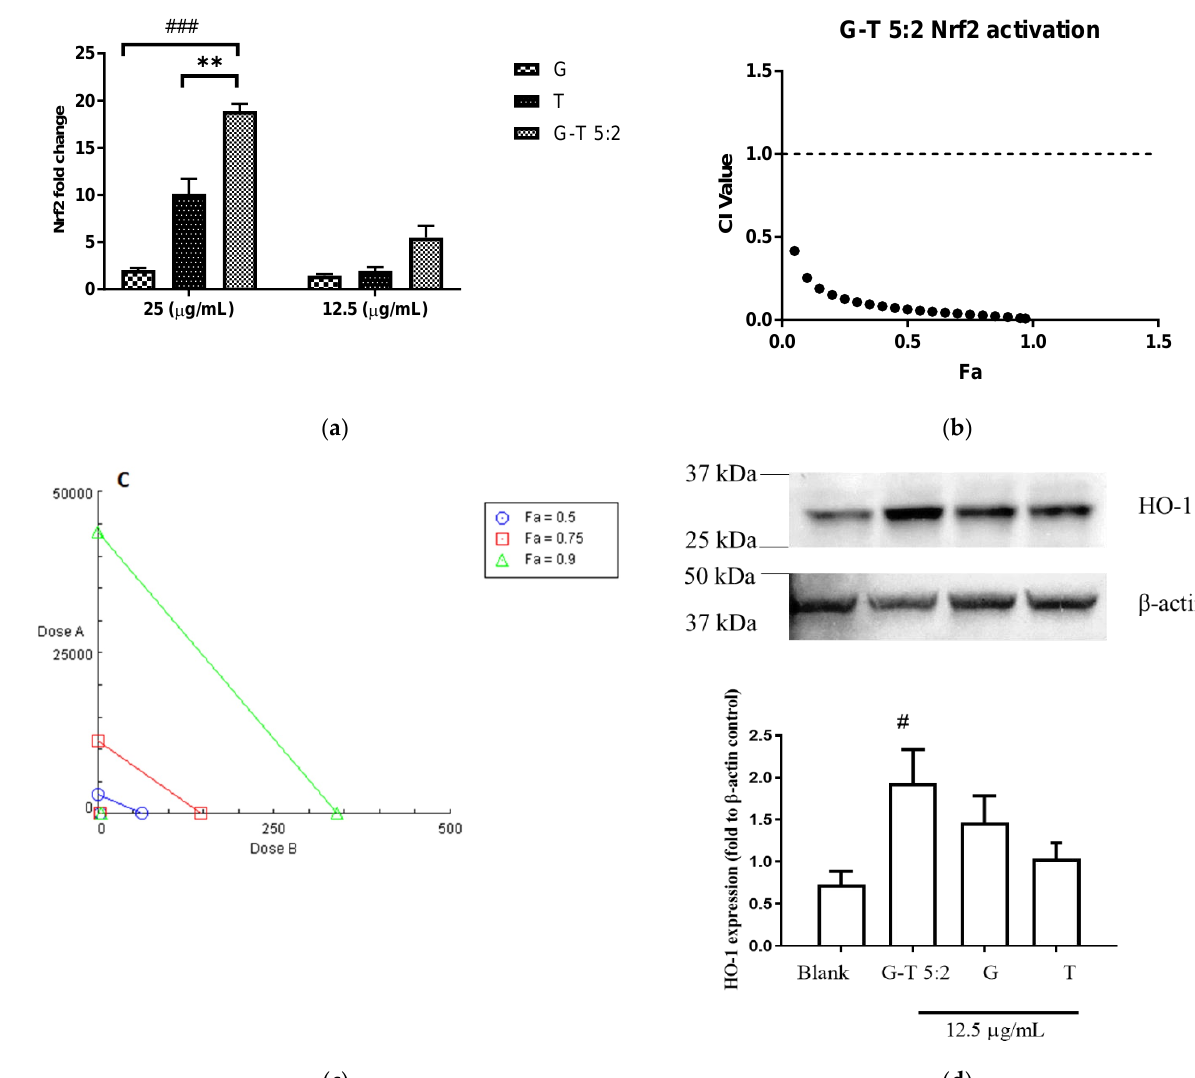
Figure 3. Up-regulatory effect of G, T and G-T 5:2 on Nrf2 and HO-1 protein levels ( n ≥ 3). ( a ) G, T and G-T 5:2 induced Nrf2 luciferase at 25 and 12.5 µg/mL ( n ≥ 3). ** p < 0.01 compared between G-T 5:2 and T at 25 µg/mL; ### p < 0.001 compared between G-T 5:2 and G at 25 µg/mL. ( b ) CI-Fa curve of G-T 5:2 in upregulating Nrf2 expression and strong synergy was observed at all tested concentration levels. ( c ) Isobologram of Nrf2 luciferase by G, T and G-T 5:2. ( d ) G-T 5:2 further strengthened the enhancement of HO-1 protein expression as analysed by western blot analysis ( n = 3). # p < 0.05 compared between G-T 5:2 and blank.